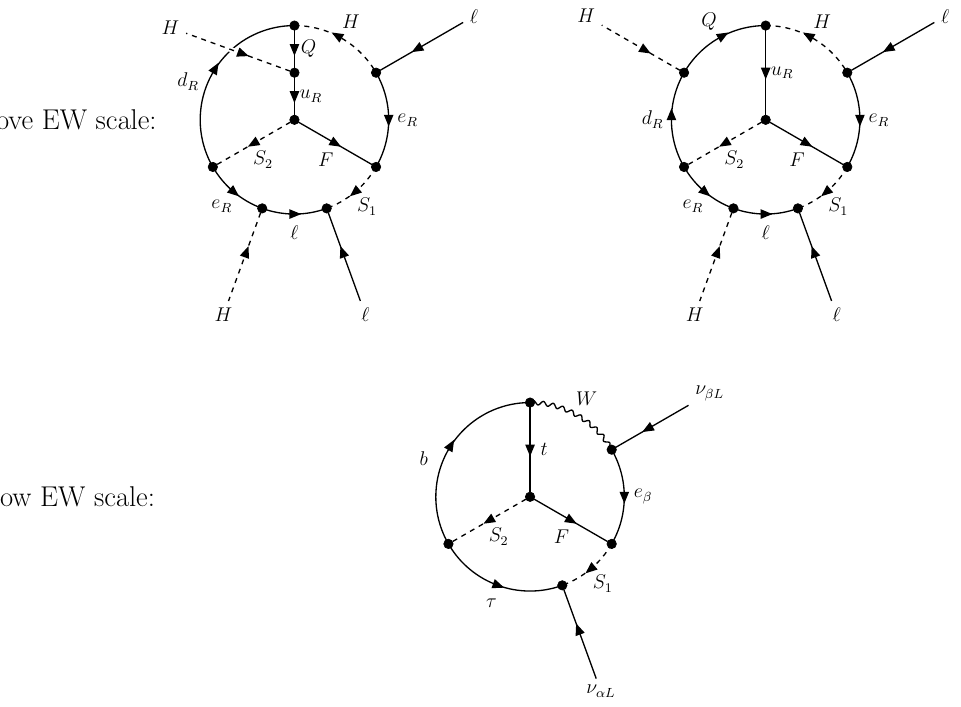
Figure 15 . The diagrams for the neutrino masses in the example model NL3-1-3-2-7-1-4 of long- range 0 νββ decay, which can generate non-zero diagonal entries of the neutrino mass matrix. Notice that u , d and e in the top panels stand for any of the right-handed up-type quarks, down- R R R type quarks and charged leptons respectively, and the two right-handed charged leptons can be different